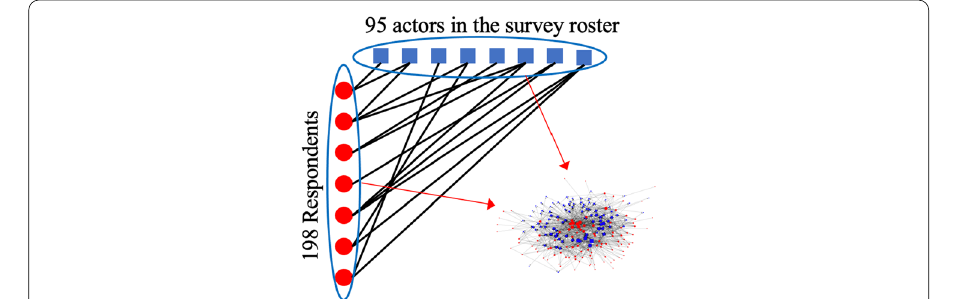
Fig. 1 Map actor collaboration network based on survey results